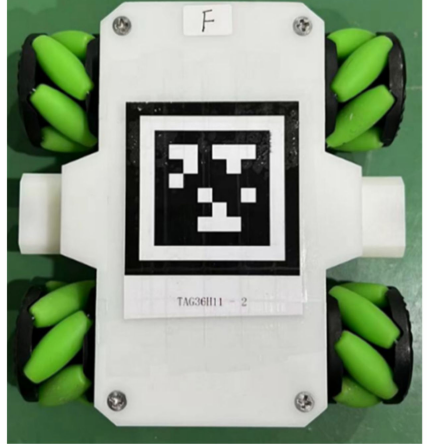
Figure 10. Modular vehicle with